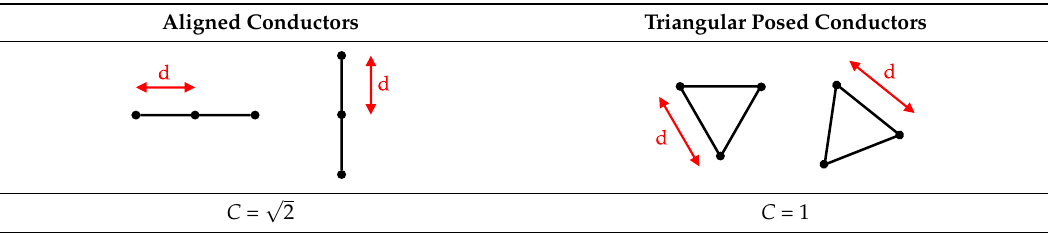
Table 1. Values of the coefficient C (dimensionless) with the phases layout.